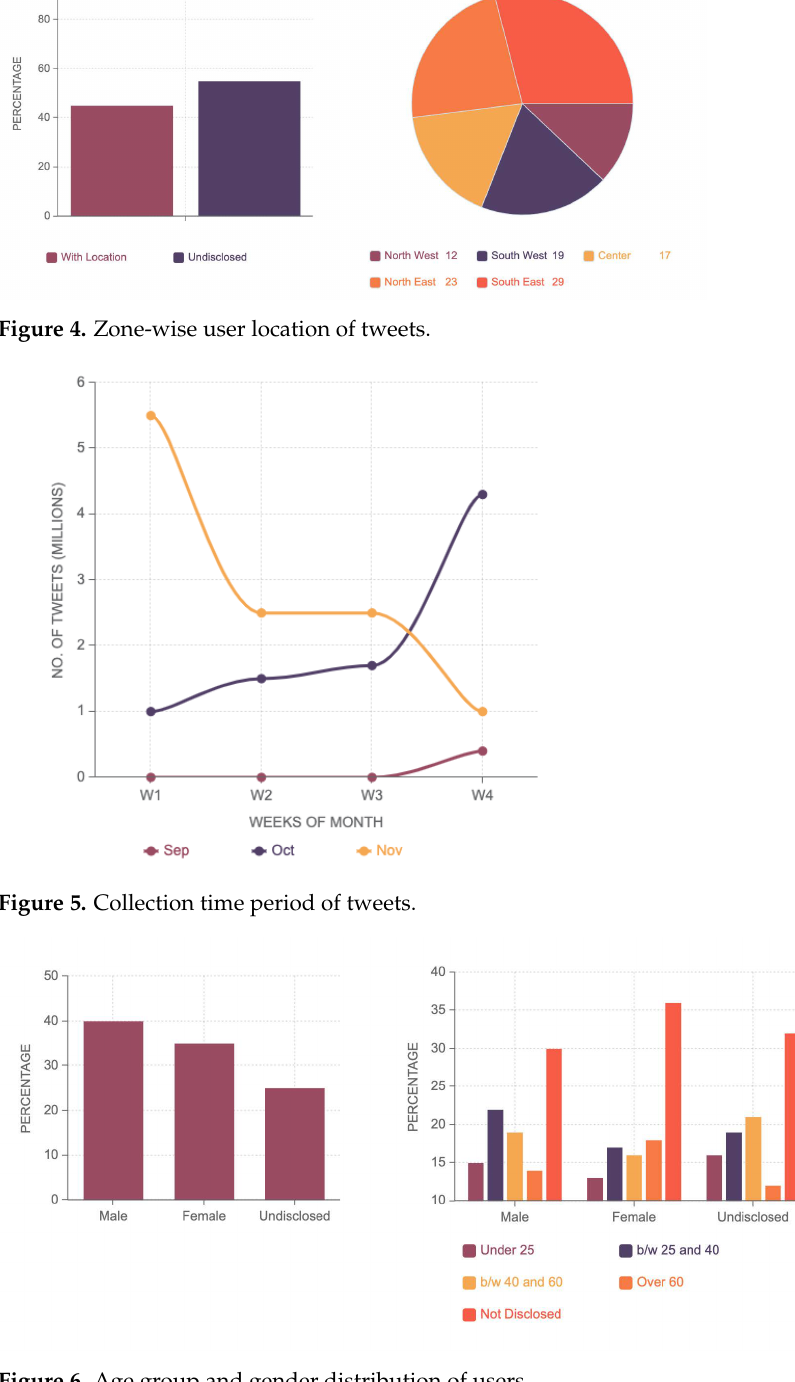
Figure 6. Age group and gender distribution of